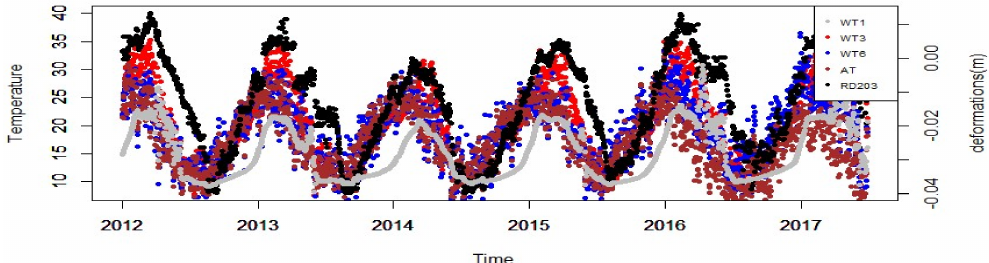
Figure 2. Roode Elsberg dam monitoring data 2012–2017 (water temperature 1 (WT1), water temper- ature 3 (WT3), water temperature 6 (WT6), ambient temperature (AT), and radial deformations 203 (RD203)), temperature in ◦